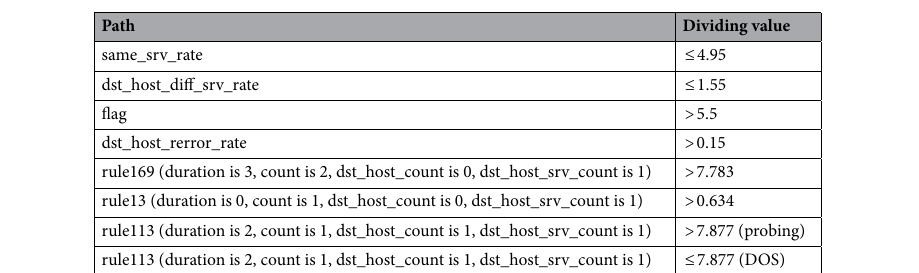
Path Dividing value same_srv_rate ≤ 4.95 dst_host_diff_srv_rate ≤ 1.55